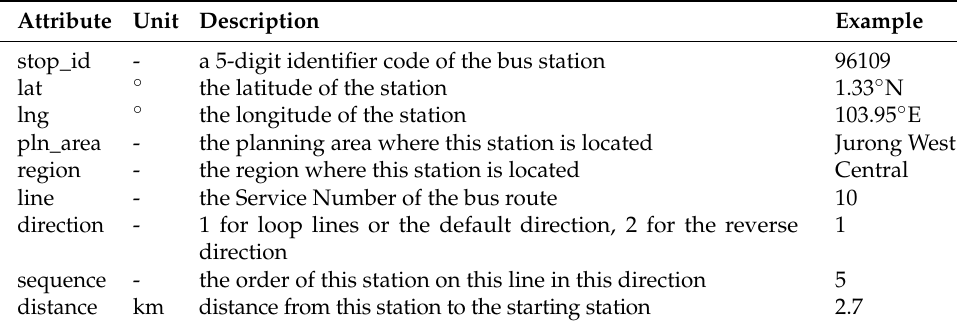
Table 6. Attribute list of the public bus system data.